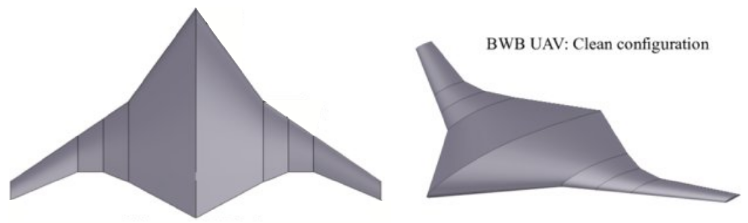
Figure 4. Blended wing body: baseline